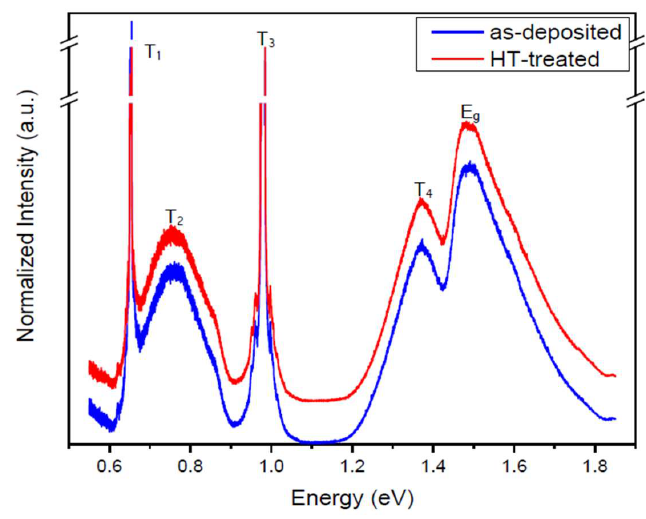
Figure 7. PL spectra obtained for as-deposited and heat-treated CdTe:Mg samples within the range of 0.5 eV to 1.9 eV.